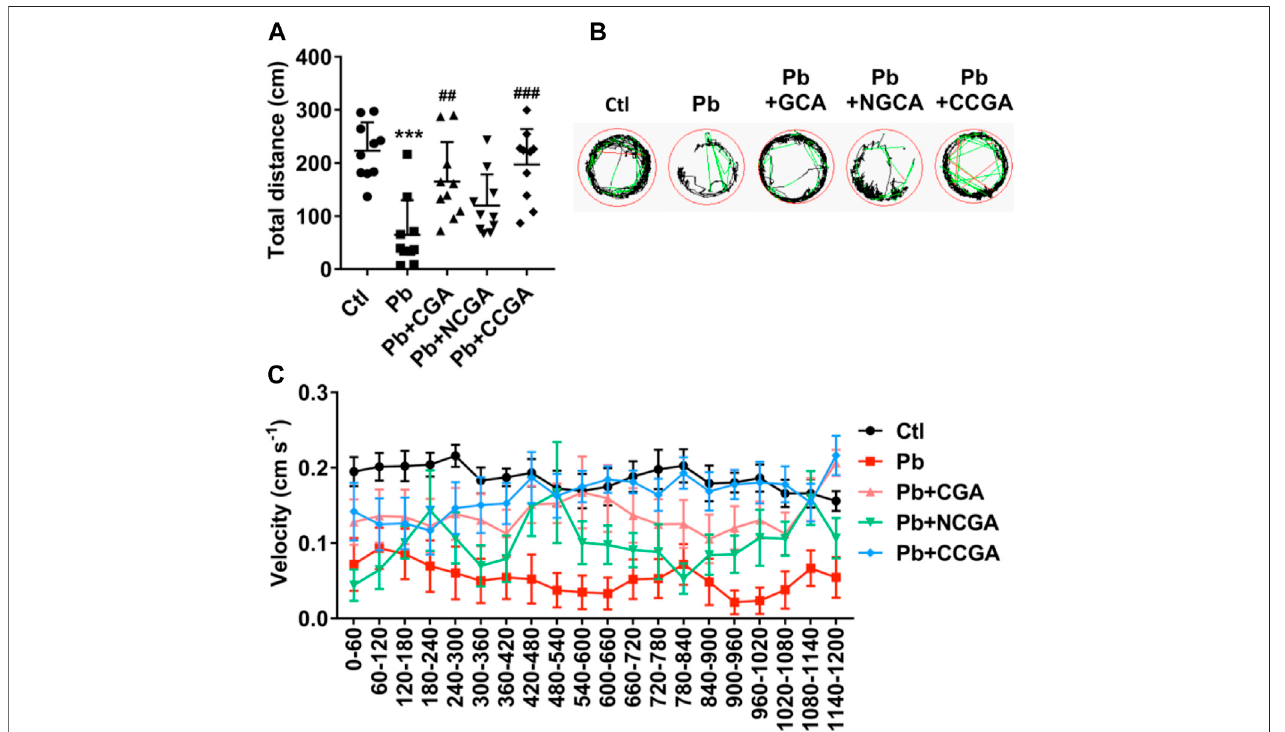
FIGURE 6 | Swimming behavior test of zebra fi sh at 120 hpf. (A) Total distance traveled in 20 min ( n (cid:1) 10); *** p < 0.001 vs. control and ## p < 0.01, ### p < 0.001 vs. Pb. (B) The digital tracking map. High-speed (v > 5 cm/s) movement is represented in red lines, medium-speed (2 cm/s < v < 5 cm/s) movement is depicted in green lines, and low-speed (v < 2 cm/s) movement is represented in black lines. (C) The swimming speed of zebra fi sh larvae with different treatment. Average speed in every 60 s was calculated.